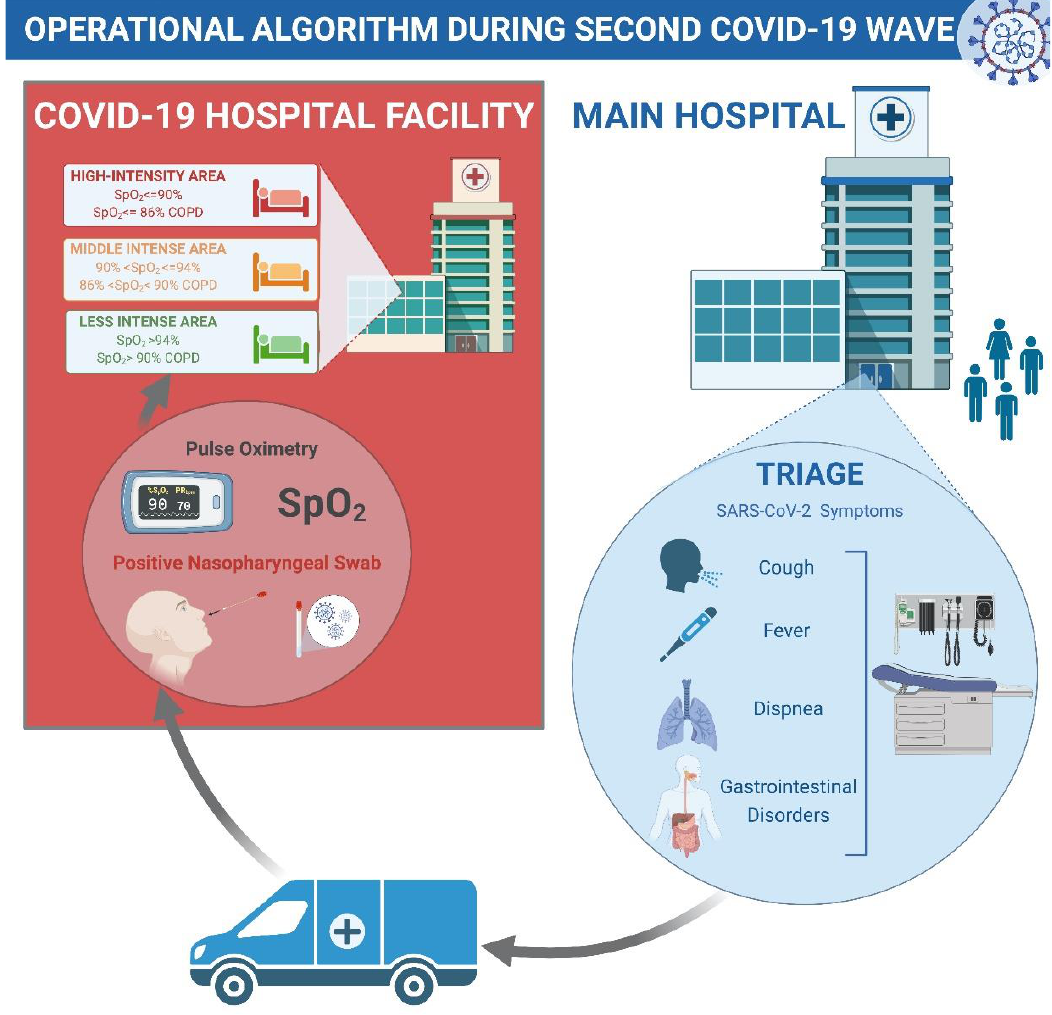
Figure 2. Operational algorithm used during the second wave of COVID-19.